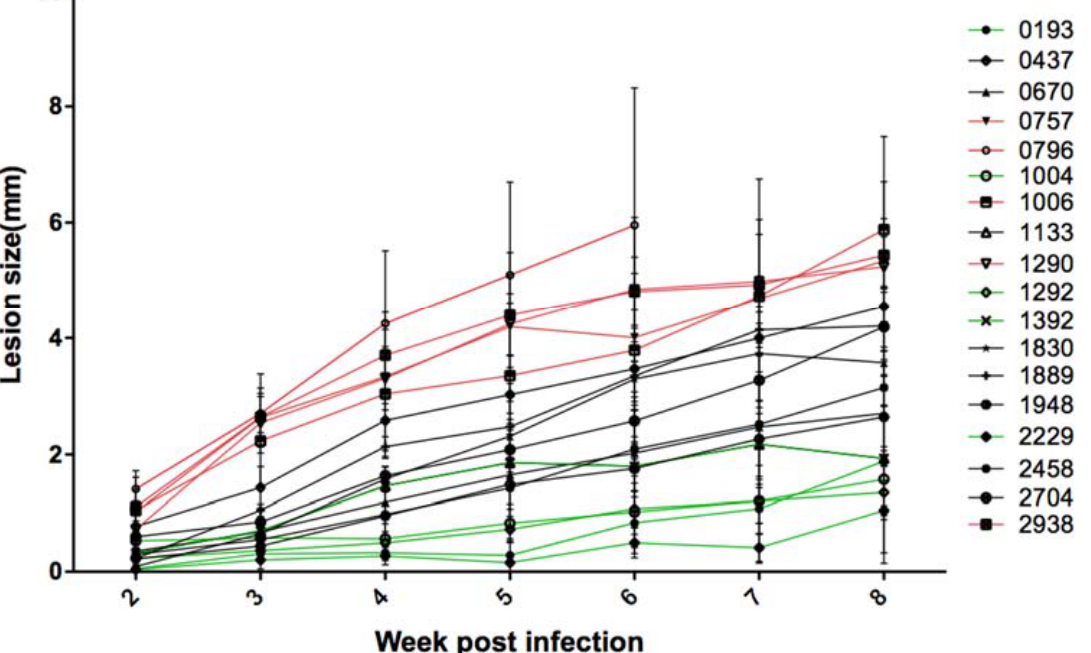
Figure 1. Lesion size of the BALB/c mice footpads infected with the 18 L. major isolates. Lesion size was monitored using the caliper every week during 8 weeks. The lesion measurement was stopped on the sixth week for a single isolate (0796) for ethical reasons. For each isolate, a group of six mice was infected. The mean and standard deviation of the six mice were presented for each isolate. The results are representative of one experiment out of two performed with six mice for each isolate. At the end of the protocol, mice were sacrificed and infected feet, draining lymph nodes, and spleens were excised and weighed. Parasite load was then monitored using limiting-dilution (Figure 2). Parasite load in infected feet correlated positively with lesion size (Spearman r value of 0.5533 and p value less than 0.0001). In the draining lymph node, parasite load correlated positively with lesion size with a Spearman r value of 0.4779 and p value less than 0.0001. Parasite load in the spleen correlated positively with lesion size (Spearman r value of 0.3379 and p value of 0.0003) (Figure